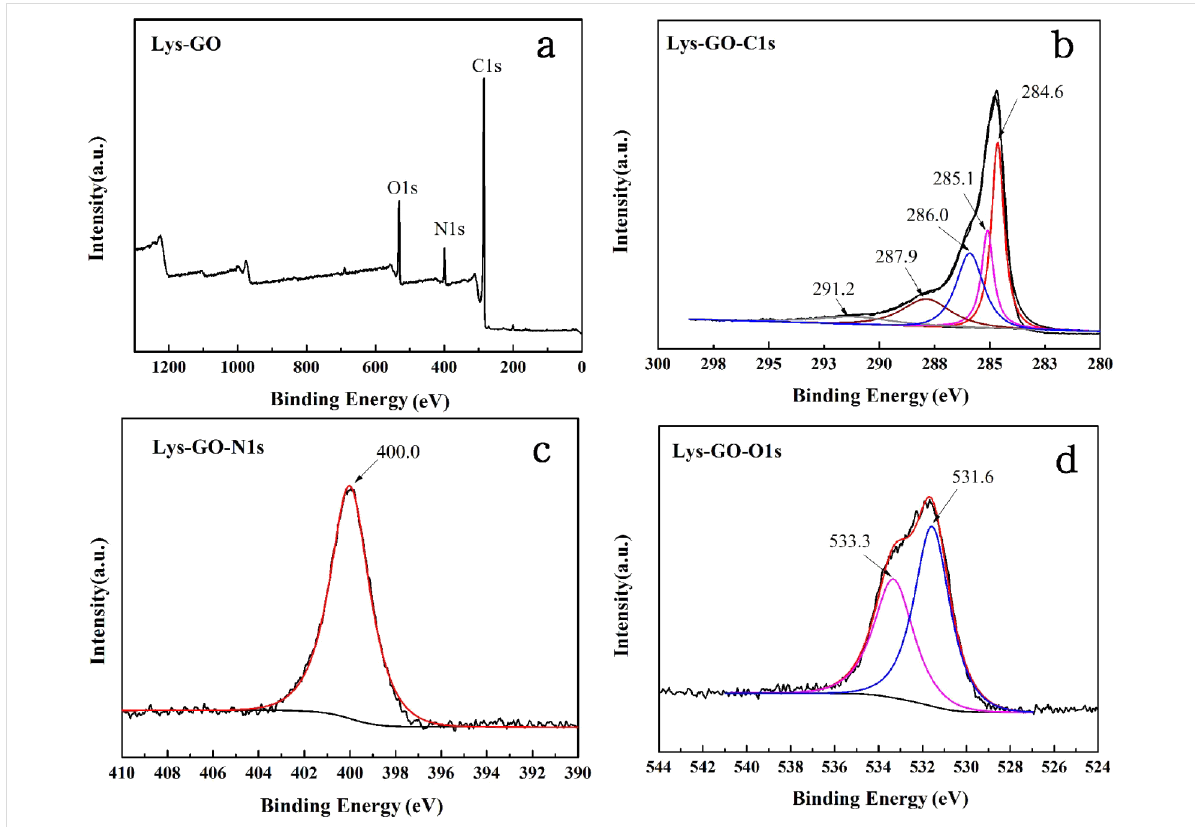
Figure 2: (a) XPS survey spectrum of Lys-GO, (b) C 1s XPS spectrum of Lys-GO, (c) N 1s XPS spectrum of Lys-GO and (d) O 1s spectrum of Lys- GO.